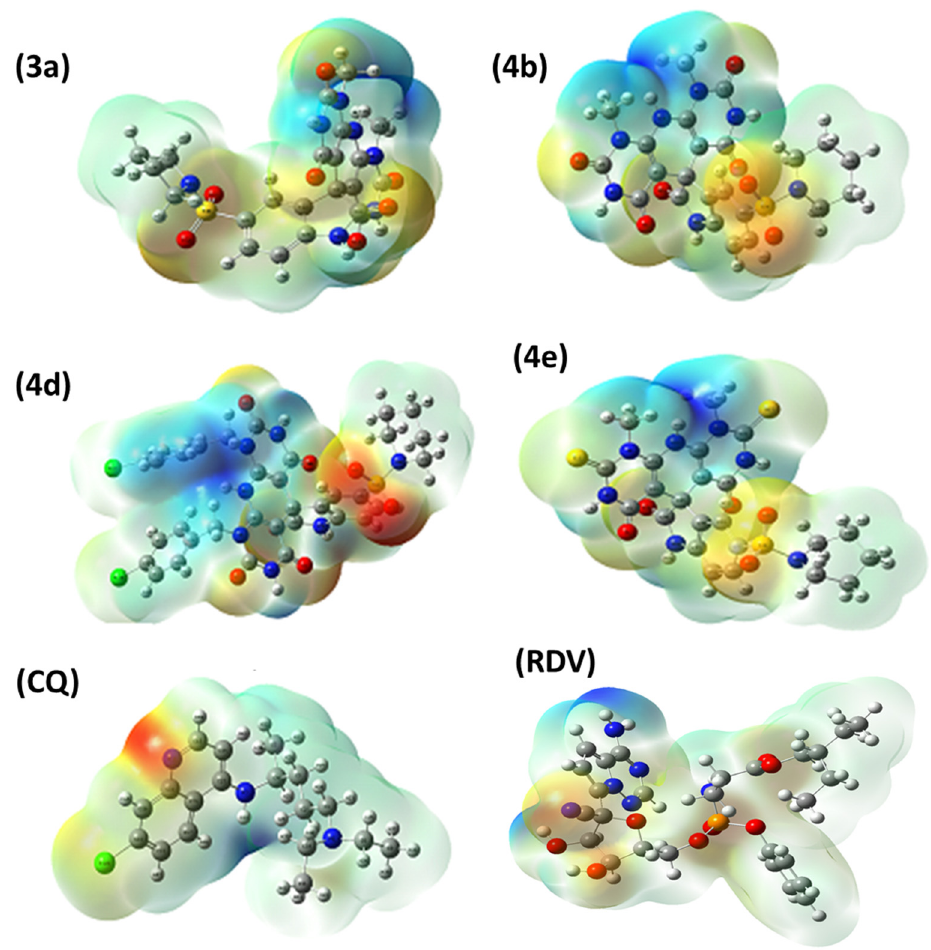
Figure 10. Molecular electrostatic maps of the most active derivatives 3a , 4b , 4d , 4e and positive controls ( Chloroquine and Remdesivir